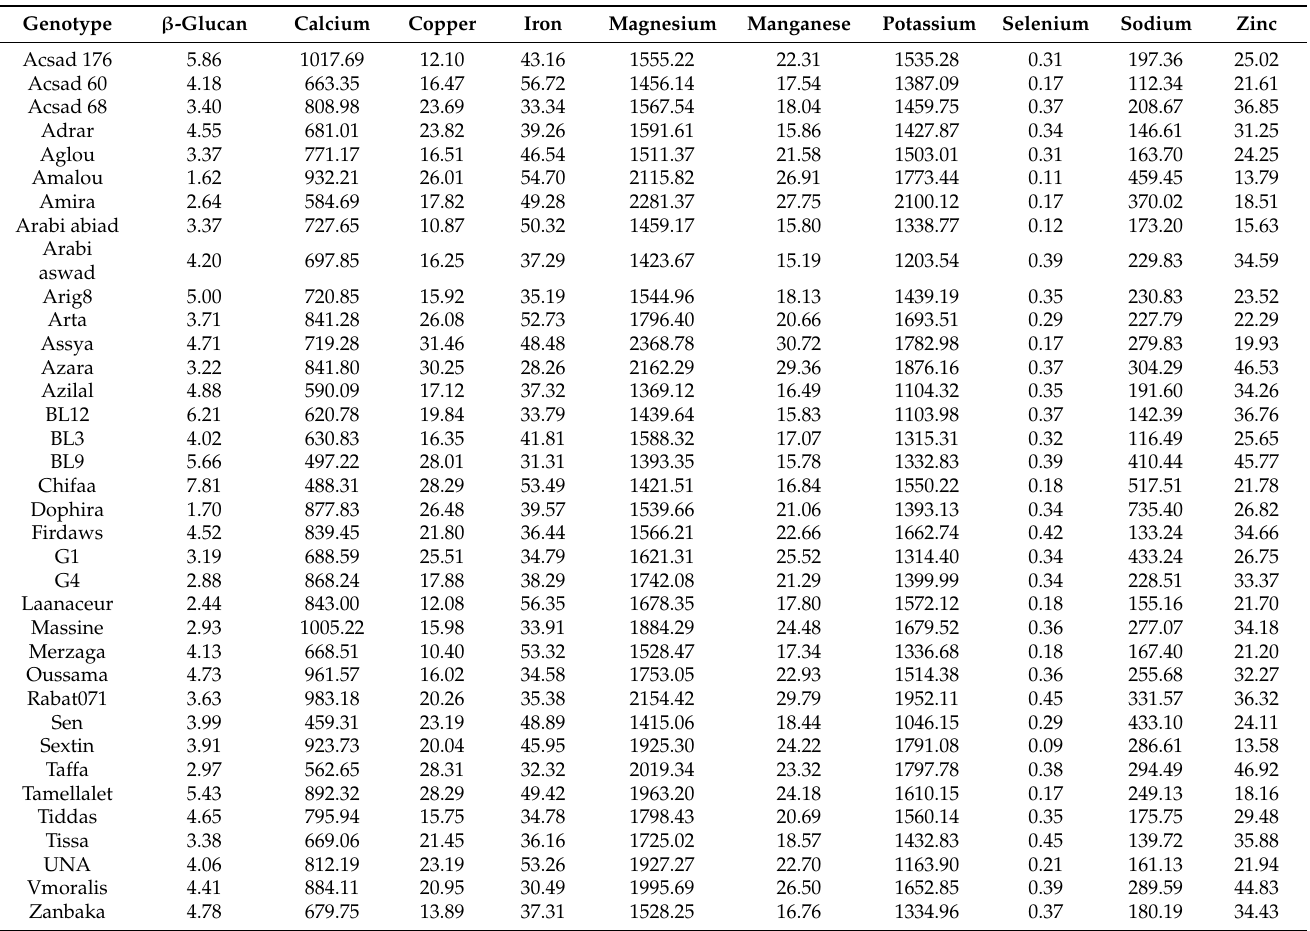
Table A2. BLUEs for elite germplasm and v cultivated barley for β -glucan microelements